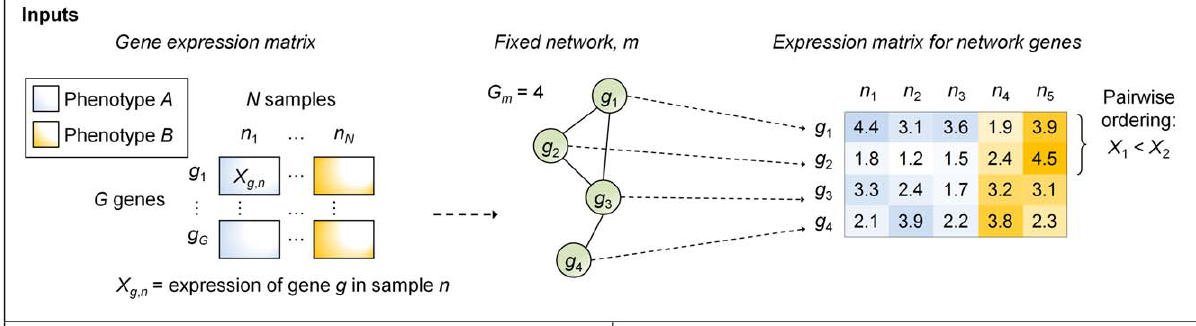
PLoS Computational Biology |